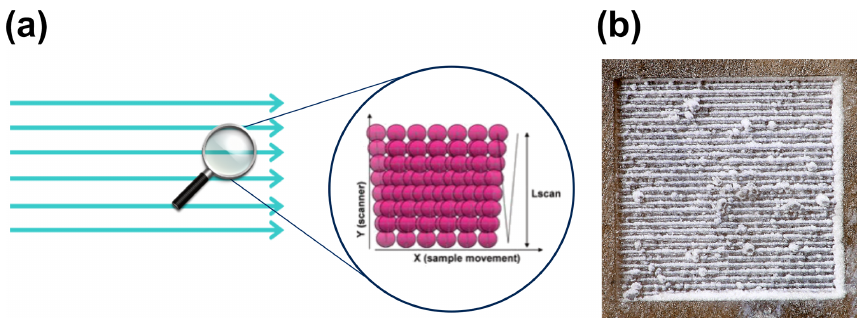
Figure 1. (a) Principle of the construction of the ablation lines with the femtosecond laser used in the study. Lscan corresponds to the width of the line – here 50 or 25µm. (b) Example of ablation produced by the rasters used for constructing an isotopic map (dimensions: 800µm ×